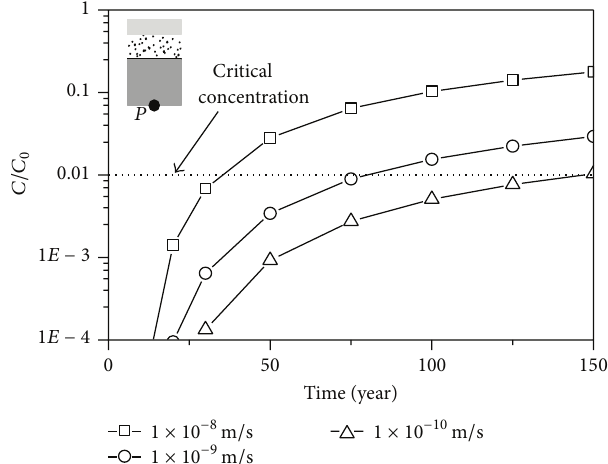
Figure 10: Comparison of numerical results with different conduc-